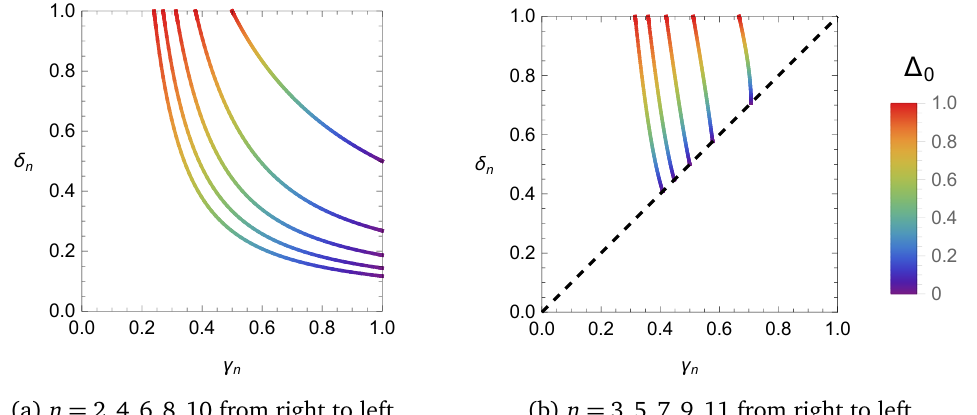
Figure 16: Coefficients γ and δ defined in (27) and (31) shown as functions of n n ∆ , for various values of n . The black dashed line in the right panel corresponds to 0 γ = δ . The numerical data show that these coefficients are always smaller than 1 n n in the whole range of ∆ considered 0